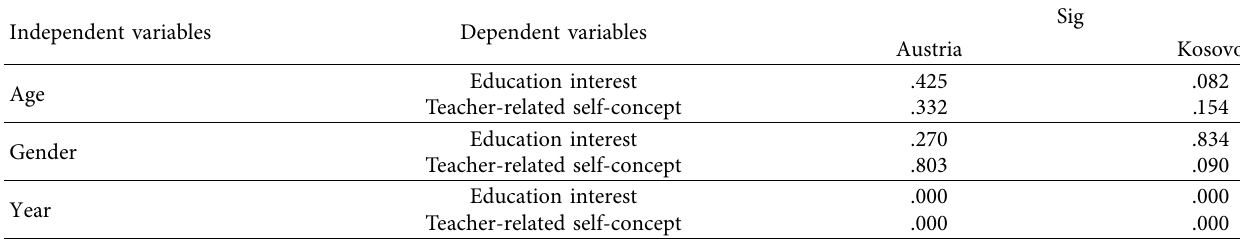
Table 5: Chi-square test between variables (cumulative data of three years).